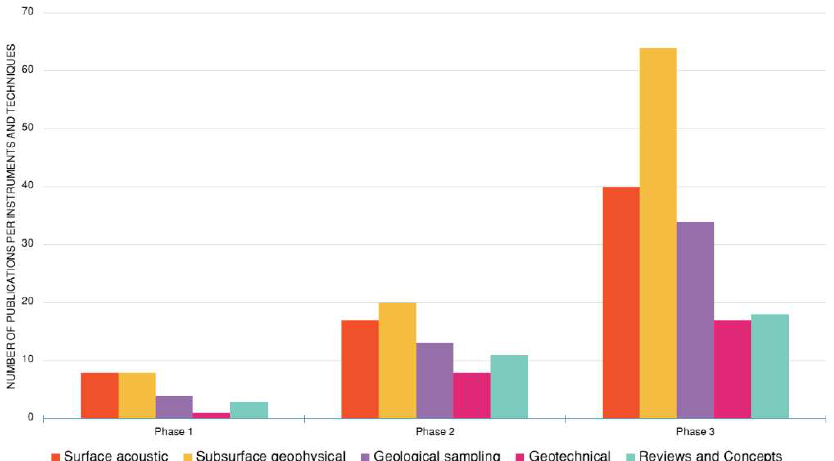
Figure 15. The number of each instrument and technique in peer-reviewed publications between 1982 and 2016.